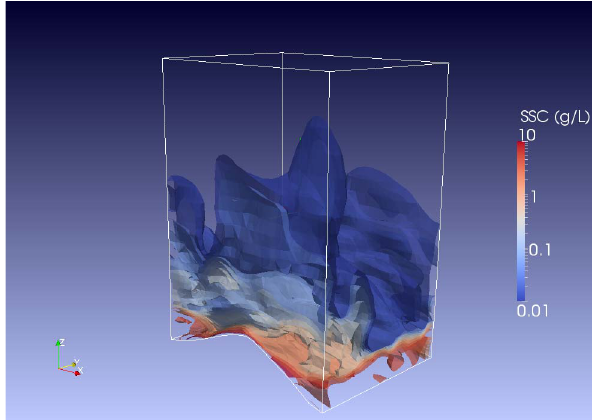
Figure 3. Contour plot of SSC in LES computations, assuming a surface roughness of z 0 = d 50 / 4, at t = 26 . 63s (phase ωt ≈ 120 ◦ ), showing significant 3-D turbulence. The lack of contours close to the ripple surface indicates extremely high SSC values.